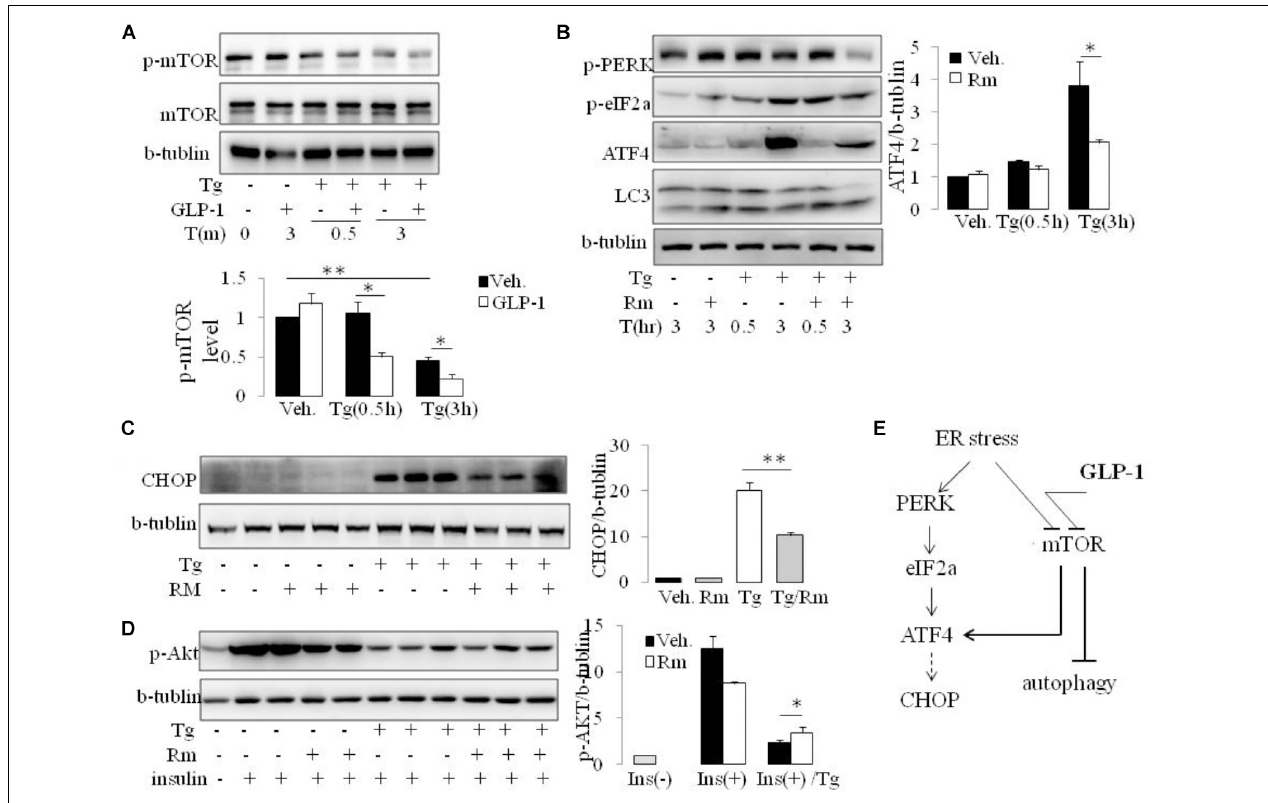
FIGURE 5 | GLP-1 affects ATF4 translation induction in adipocytes following ER stress via preventing mTOR signaling pathway. (A) The differentiated adipocytes were fasted for 16 h in low-glucose DMEM media with 0.2% BSA (fasting media) and then were exposed to vehicle alone or thapsigargin (Tg) in the absence or presence of GLP-1 in fasting media for 0.5–3.0 h as indicated. Three wells of cell extracts were pooled together and were analyzed by immunoblotting for P(2448)-mTOR, mTOR, and b-tublin (loading control). Data represent means ± SE of four independent experiments. ∗ P < 0.05 and ∗∗ P < 0.01. Data for replication see Supplementary Figure 5 . (B) The differentiated adipocytes were fasted for 16 h in fasting media and then were exposed to vehicle alone or thapsigargin (Tg) in the absence or presence of rapamycin (Rm) in fasting media for 0.5–3.0 h as indicated. Three wells of cell extracts were pooled together and were analyzed by immunoblotting for ATF-4, P(Ser51)-eIF2a, P(Thr980)-PERK, LC3 and b-tublin (loading control). Data represent means ± SE of three independent experiments. ∗ P < 0.05. (C,D) The differentiated adipocytes were fasted for 6 h in fasting media and then were exposed to vehicle alone or thapsigargin (Tg) in the absence or presence of rapamycin (Rm) in fasting media for 16 h. Three wells of cell extracts were pooled together and were analyzed by immunoblotting for CHOP, phospho-AKT Ser47 (p-AKT) and b-tublin (loading control). Data represent means ± SE of three independent experiments. ∗ P < 0.05 and ∗∗ P < 0.01. (E) Model depicting the proposed mechanism of effects of GLP-1 on ER stress in